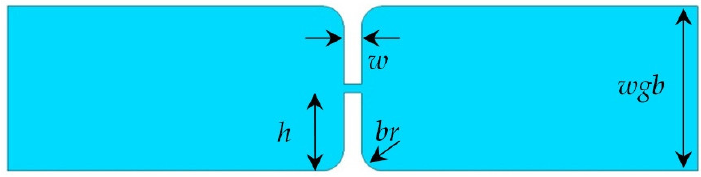
Figure 3. RWG symmetric E-plane iris (side view, air inside metallic background).